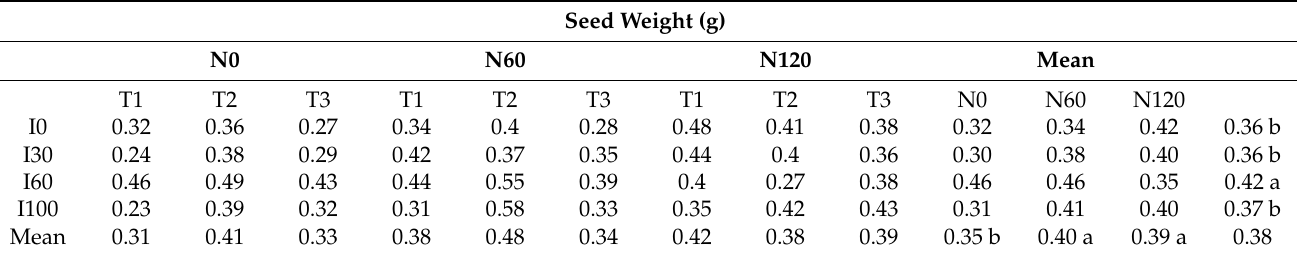
Table 3. Seed weight (g) in relation to irrigation (I0, I30, I60, and I00 = 0, 30, 60, and 100% ETm, respectively) and N level (N0, N60, and N120 = 0, 60, and 120 kg ha − 1 N) of primary and secondary racemes in 2021 and secondary racemes in 2022 (T1, T2, and T3). In the mean columns, the average values of all N levels (last row) and the average values of all irrigation levels (last column) followed by the same letter did not significantly differ at p ≤ 0.05. Seed Weight (g)